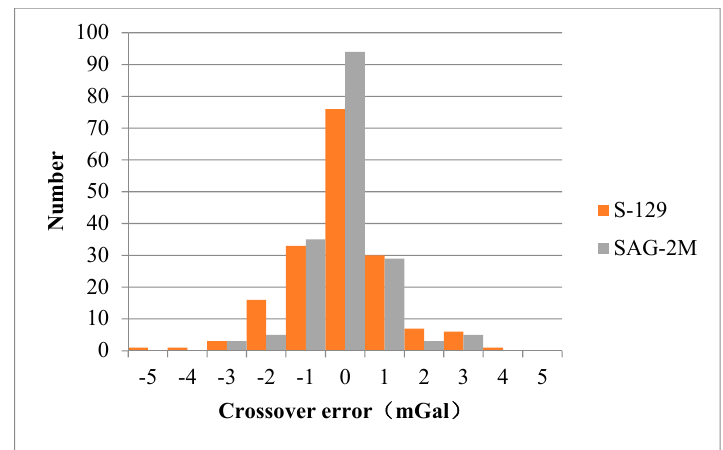
Figure 10. Comparison results of the crossover points of the S-129 and the SAG-2M sea-air gravimeters.